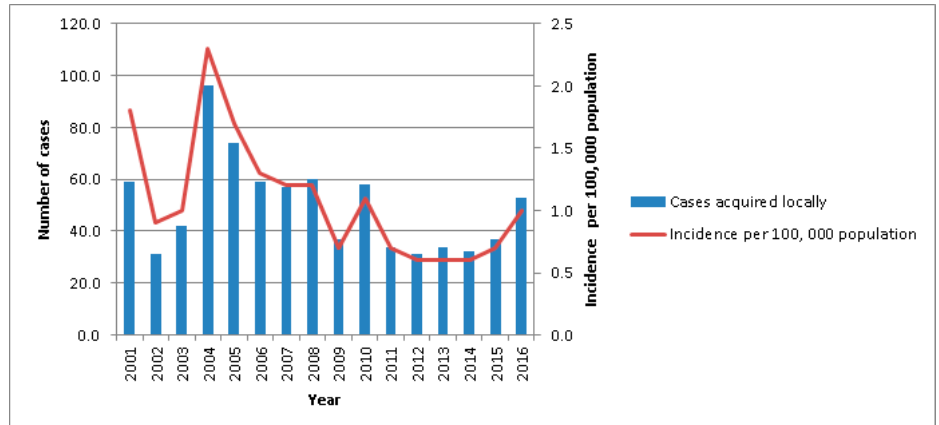
Figure 1. Annual number of human melioidosis cases from 2003 to 2016 in Singapore.